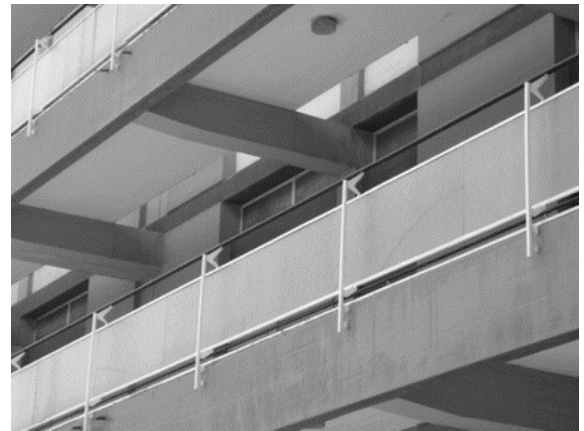
Figure 14. Rear façade: the exterior galleries.